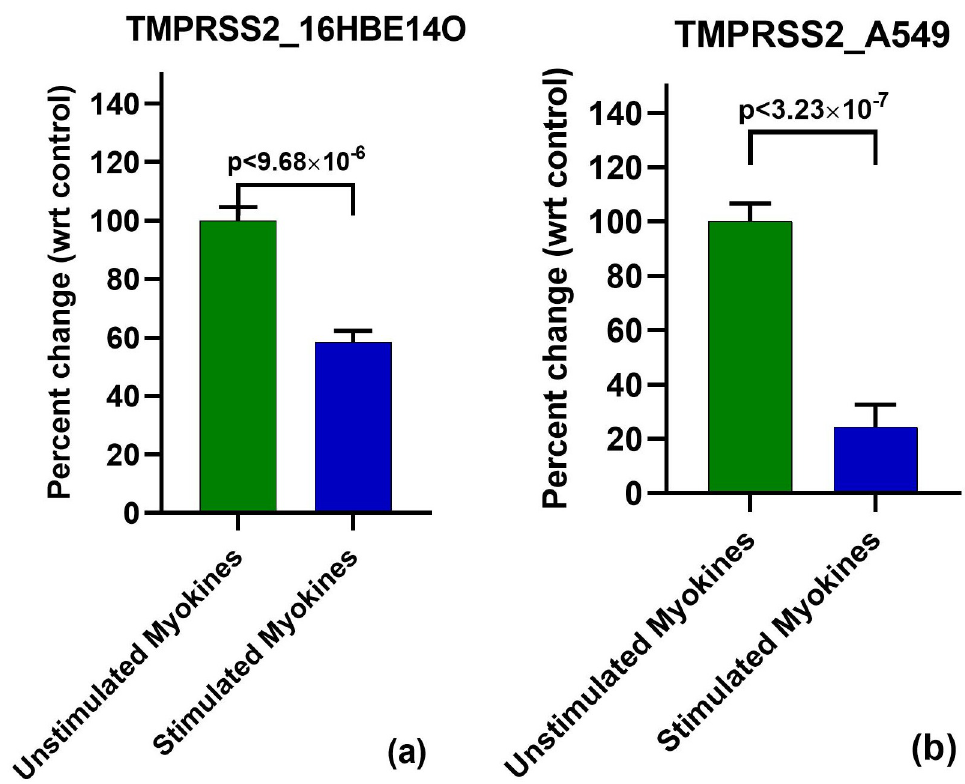
Fig 3. Downregulation of TMPRSS2 mRNA with 48 h stimulated myokine treatment. (a): TMPRSS2 qPCR in 16HBE14o . Real time pcr revealed a 41% reduction of TMPRSS2 mRNA with stimulated myokines. (b): TMPRSS2 qPCR in A549 . Stimulated myokine treatment reduced TMPRSS2 gene expression by